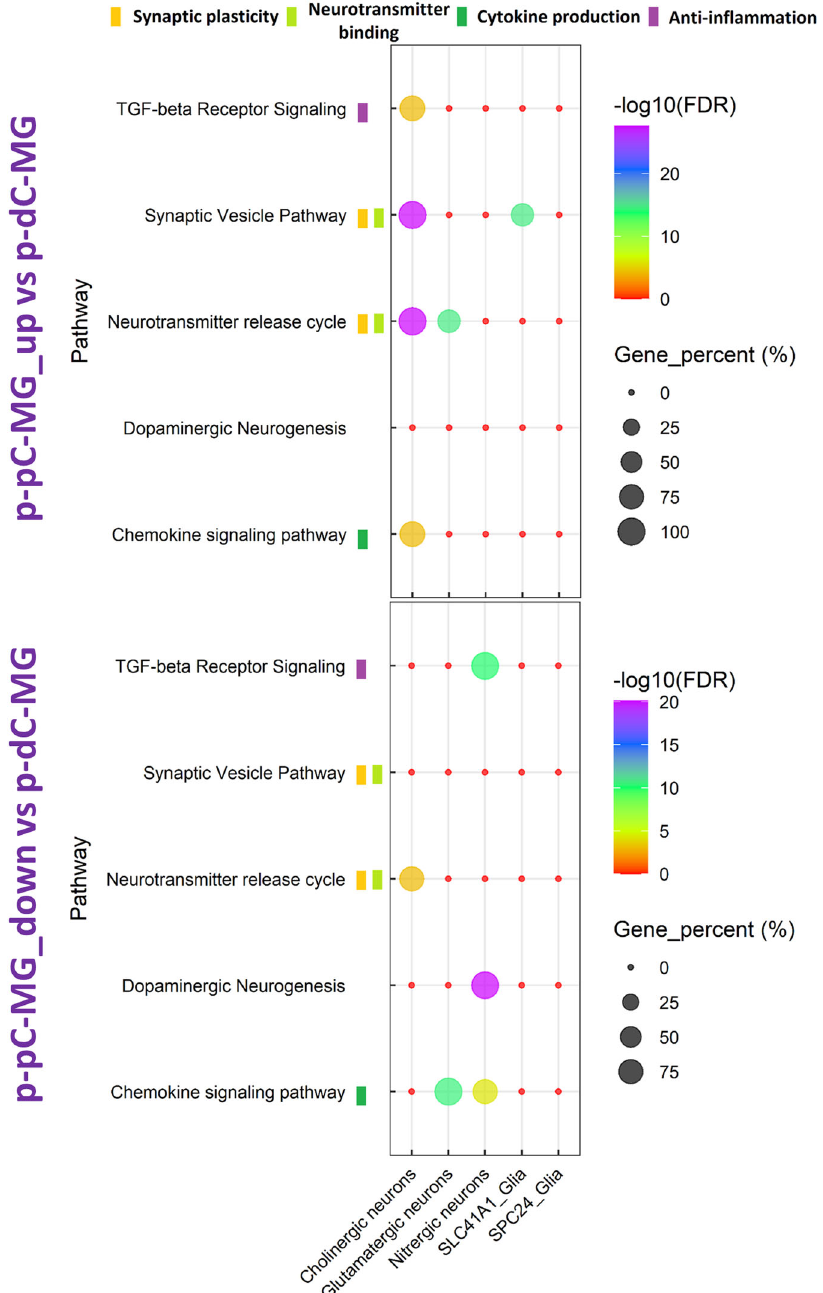
Fig. 6 Comparison of cell-type speci fi c pathway enrichment in myenteric ganglia (MG) between porcine proximal and distal colon (p-pC, p-dC). The bubble plot shows the gene percentage and enrichment of WikiPathways. Circle size represents the ratio of the number of cell-type pathway-speci fi c differentially expressed genes (DEG) and the number of total DEG in each DEG list (Gene_percent). Color represents a -log10 (FDR) distribution from big (orange) to small (purple). The color bars mean the speci fi ed WikiPathway classi fi ed into designated clusters. Up, upregulated expression. Down, downregulated